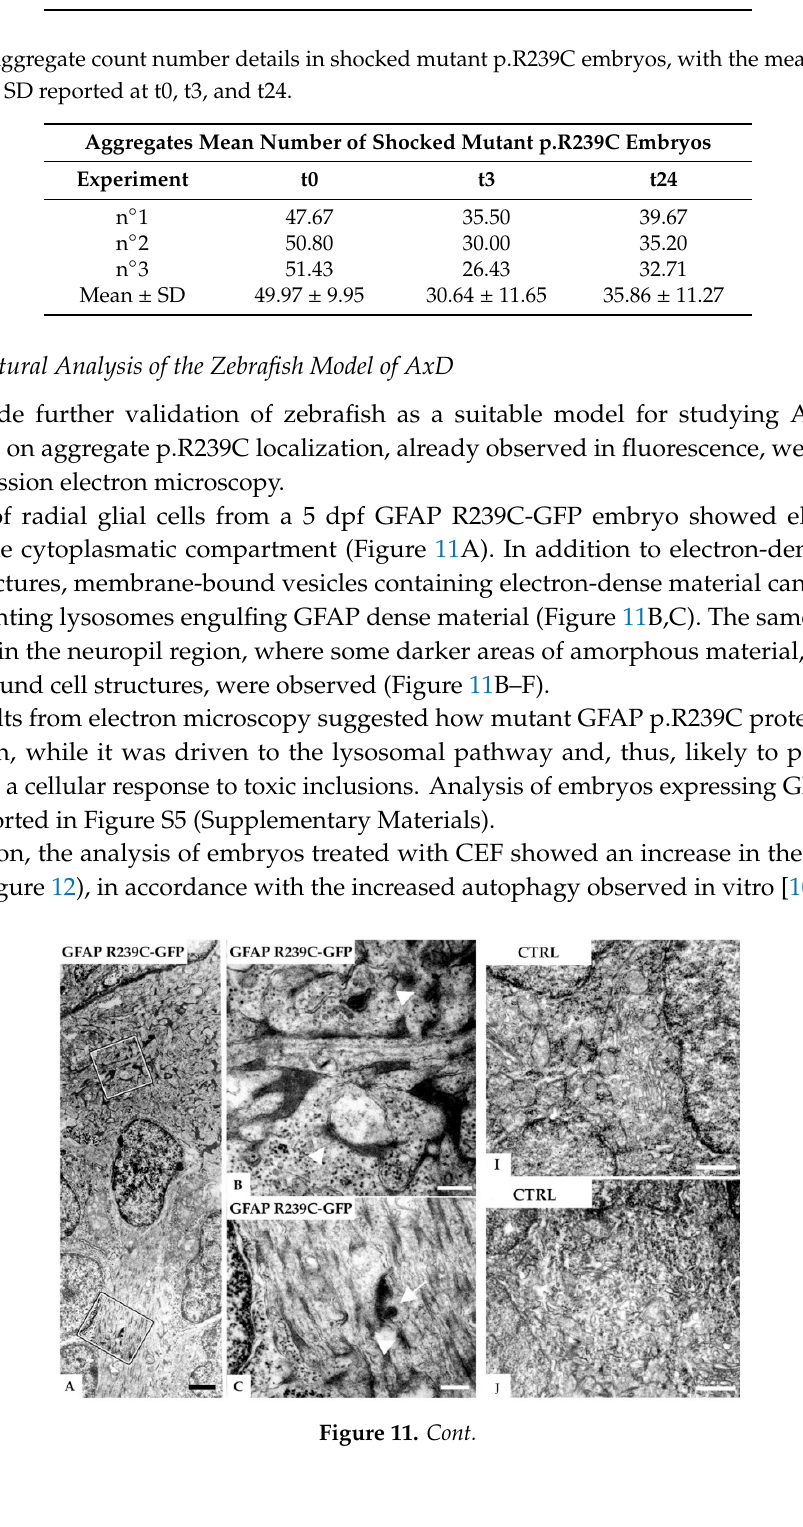
Figure 11. Electron micrographs of radial glial cells in the subventricular and neuropil region in the telencephalon of a 5 dpf zebrafish injected with GFAP-R239C-GFP plasmid. ( A ) A glial cell contacts the ventricular brain surface covered by the tela choroidea (top) and shows many electron-dense profiles. In ( B , C ), higher magnifications of the marked areas in ( A ) reveal that the dark profiles are associated with filaments (arrowheads) and sometimes surrounded by a membrane (arrows), the latter consistent with lysosomal packaging. In another example of the neuropil region shown in ( D ), at higher magnifications of the marked areas depicted in ( E , F ), glial processes containing electron-dense fibrillar material can be seen (arrowheads). The arrow points at a membrane-bound vesicle containing clustered electron-dense material, featuring a lysosome. In ( G – J ), electron microscopic analyses on control wildtype embryos of similar regions are shown, i.e., subventricular glial processes in ( G , H ) and neuropil region in the telencephalon in ( I , J ). No such electron-dense material in glial processes, identified by their irregular shape in the synaptic regions (arrows), was detected in the control tissue. Note that the dark bands are postsynaptic densities (S: presynaptic terminals). Scale bars: ( A , D ) 1 μ m; ( B – C ) 250 nm; ( E – J ) 500 nm. Our results from electron microscopy suggested how mutant GFAP p.R239C protein was prone to aggregation, while it was driven to the lysosomal pathway and, thus, likely to partial protein elimination as a cellular response to toxic inclusions. Analysis of embryos expressing GFAP-WT-GFP protein is reported in Figure S5 (Supplementary Materials). In addition, the analysis of embryos treated with CEF showed an increase in the formation of lysosomes (Figure 12), in accordance with the increased autophagy observed in vitro [10].